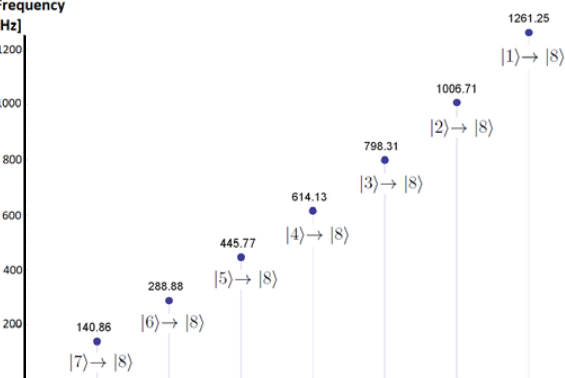
Figure 7. Planck’s constant h , the mass of the neutron m and local gravity g define a series of frequency, here exemplarily demonstrated for acoustic transitions between | 7 (cid:4)→ | 8 (cid:4) at 140.86 Hz and | 1 (cid:4) → | 8 (cid:4) at 1261.25 Hz. In this paper the frequencies ν are rounded to two decimal places. Such a frequency resolution is reached during a time span of 10 s taking the classical uncertainty relationship (cid:5)ω × (cid:5) t = 1